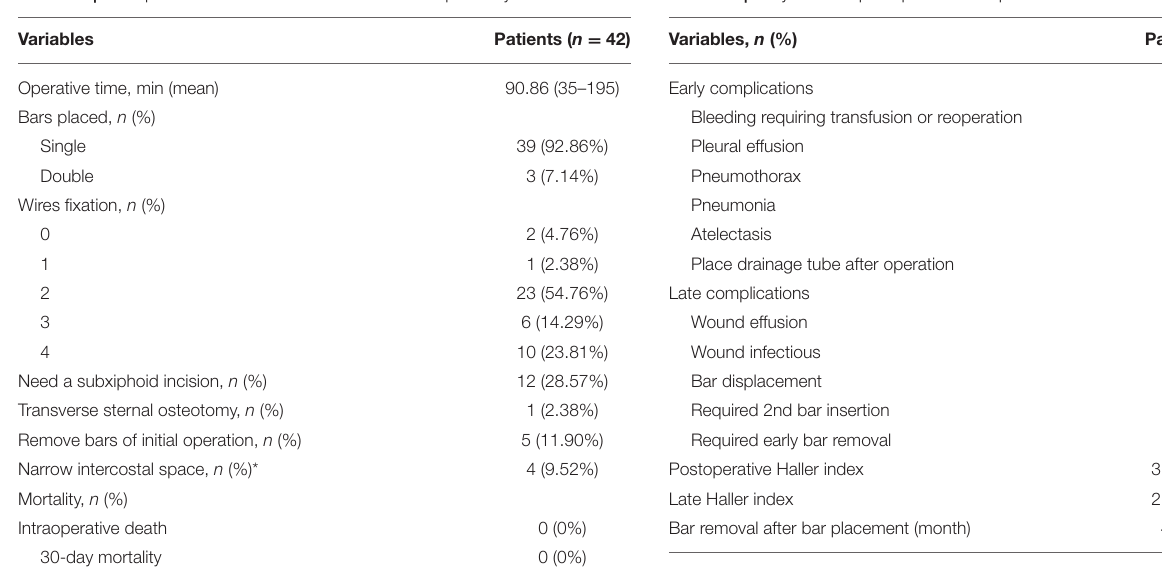
TABLE 2 | Intraoperative variables and data from the hospital stay. TABLE 3 | Early and late postoperative